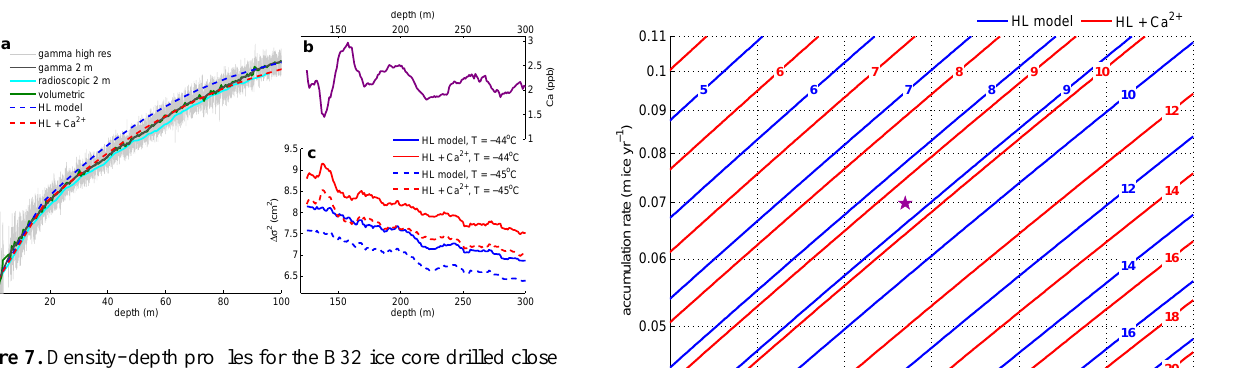
Figure 7. Density–depth profiles for the B32 ice core drilled close to the main EDML ice core (a) . Density was measured volumetri- cally, using gamma ray attenuation and with radioscopic imaging. The dashed lines show the density profiles calculated with the clas- sical Herron–Langway model and with the Herron–Langway model adjusted using the average Ca 2 + concentration of 1.7ppb (Freitag et al., 2013b). (c) shows the differential diffusion lengths calculated using the classical model and the Ca 2 + -adjusted model for two dif- ferent temperatures. The visible decreasing trend is mostly due to the progressive thinning of the ice. The Ca 2 + concentration used in the calculations is shown in (b) .